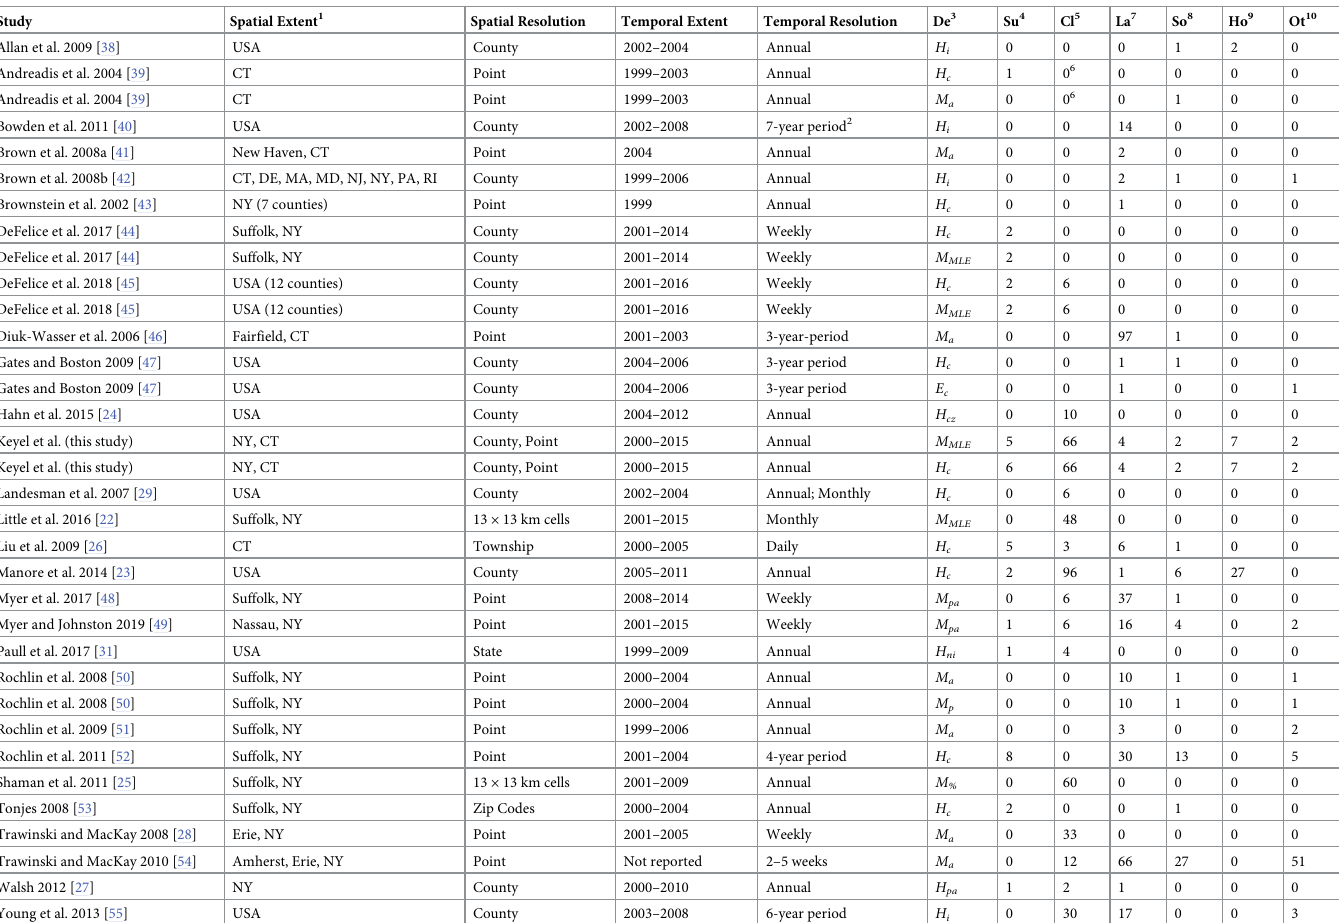
Table 1. A summary of literature that includes Connecticut or New York as part of the study area. Studies varied in their choice of dependent variable (De). Indepen- dent variables were classified as Surveillance (Su), climate (Cl), land cover (La), Sociological (So), host-related (Ho), or Other